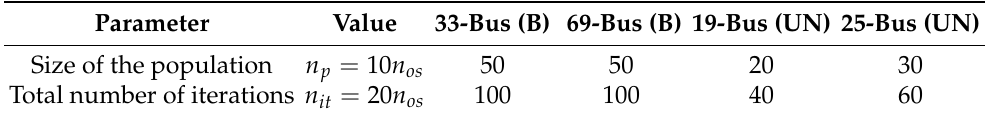
Table 2. SBAT variable